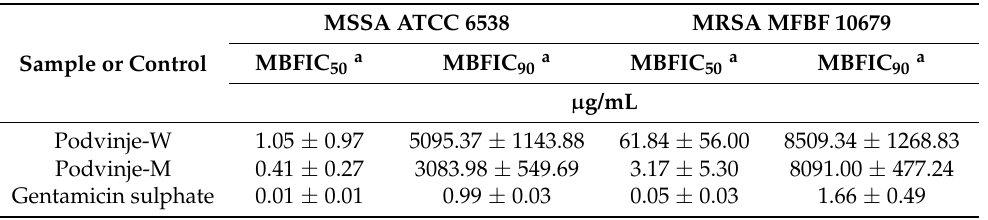
Table 3. Anti-biofilm activity of water (Podvinje-W) and methanolic (Podvinje-M) E. cicutarium extracts from the Podvinje locality on MSSA and MRSA (results shown as mean ± S.D; N = 3).